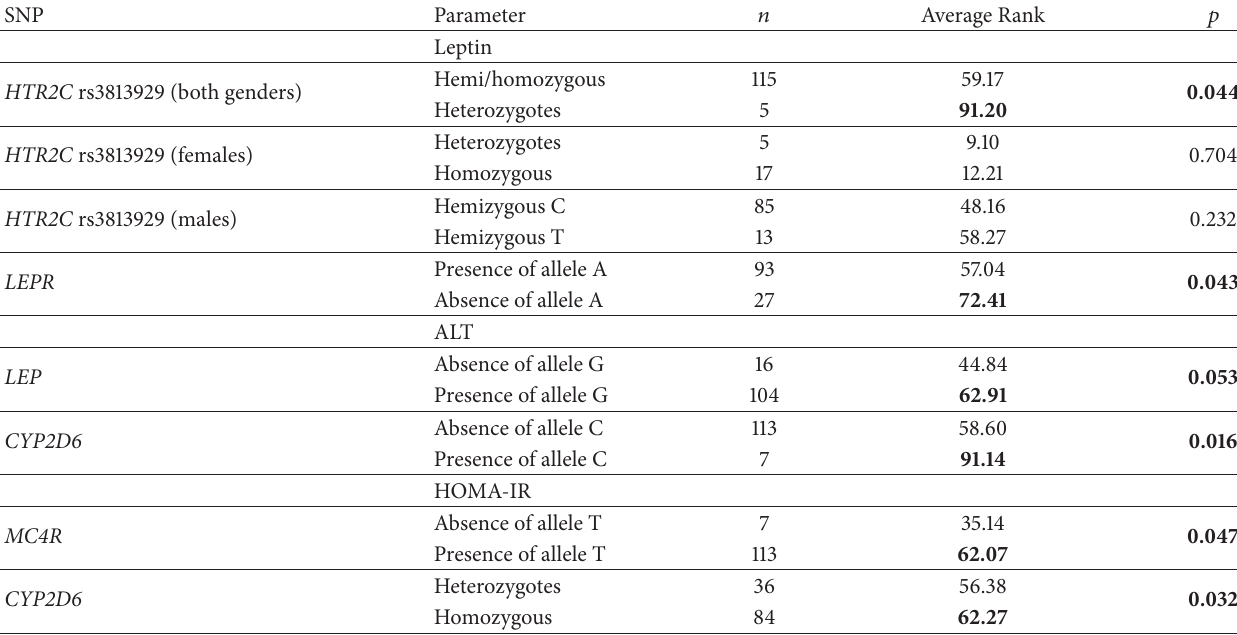
Table 5: Average rank (Mann-Whitney test) of continuous variables evaluated in relation to the SNP alleles ( 𝑛 = 120